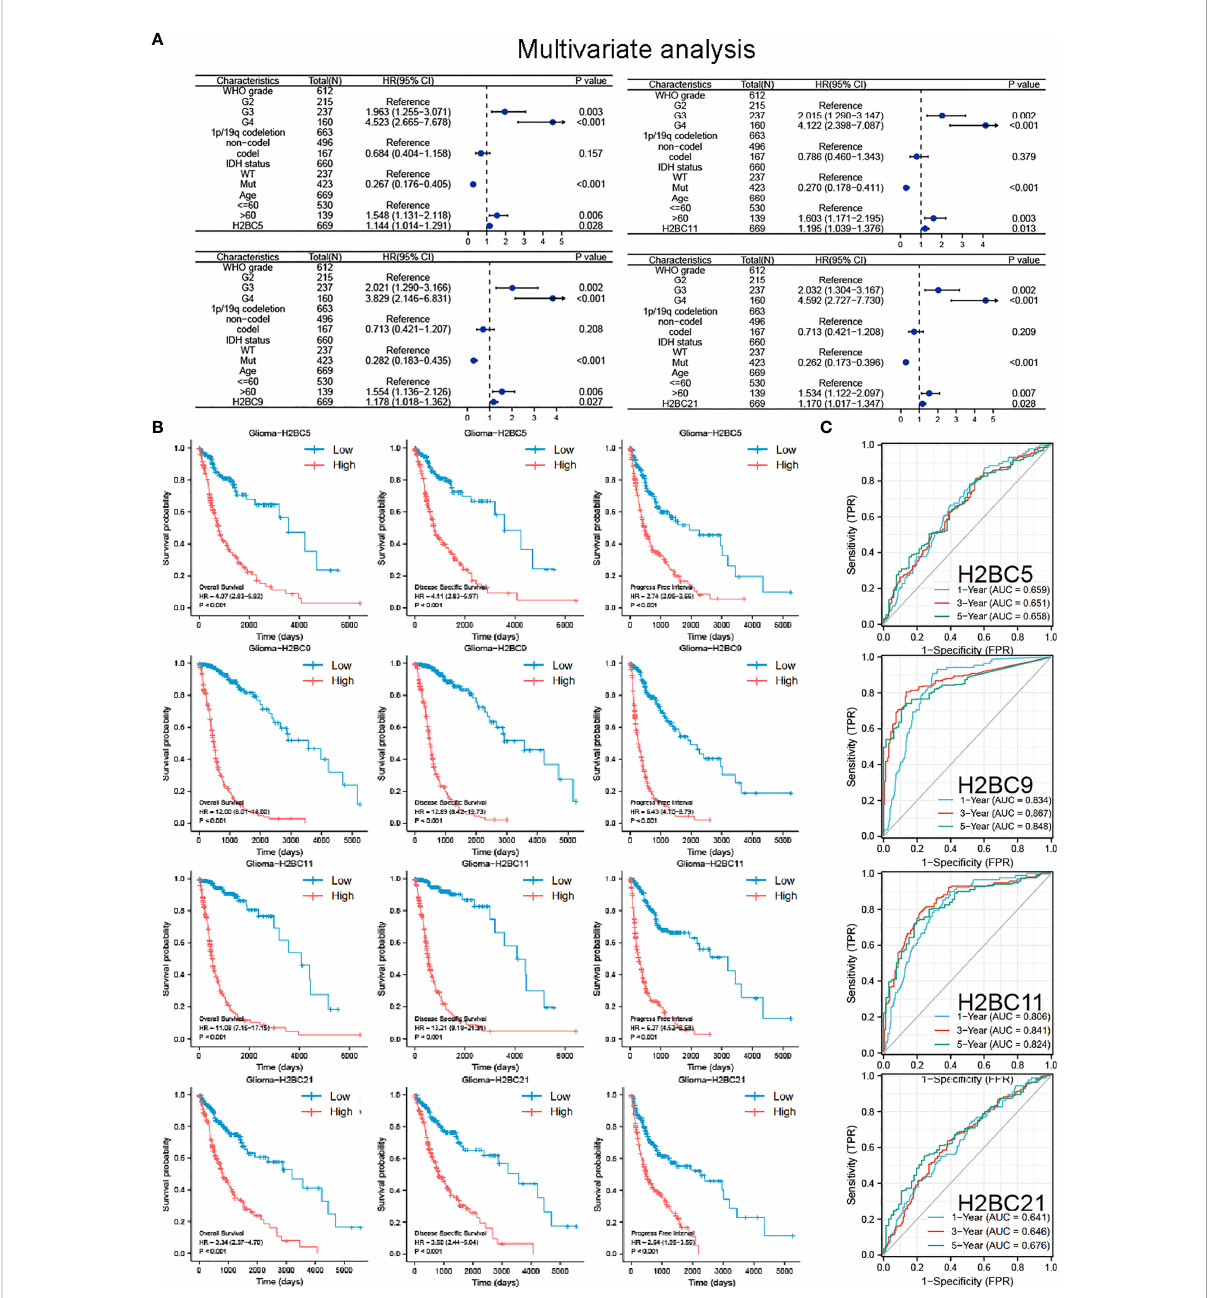
FIGURE 3 COX regression analysis, Kaplan-Meier survival analysis, and ROC curve of H2BC5, H2BC9, H2BC11 and H2BC21. (A) Multivariate Cox regression analyses using TCGA cohorts. Kaplan-Meier survival analysis correlated high expression of H2BC5, H2BC9, H2BC11, H2BC21 with the poor prognosis of OS, DFS, and PFI for glioma patients using the (B) TCGA databases. (C) ROC curves of glioma overall survival demonstrate the sensitivity and speci fi city of the predictive power of H2BC5, H2BC9, H2BC11, and H2BC21. P<0.05 is considered statistically signi fi